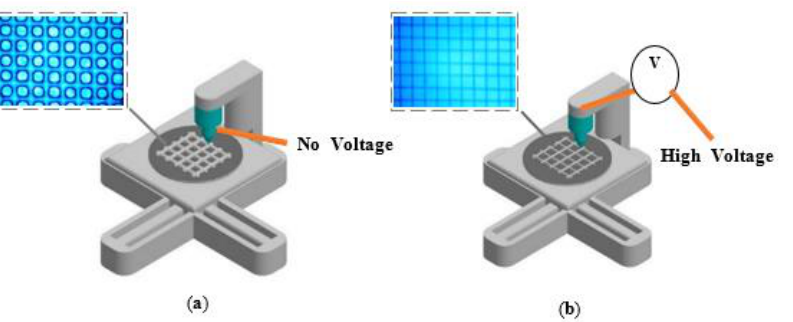
Figure 1. Two types of printing methods to fabricate microscale PDMS mesh patterns. ( a ) Direct ink writing and ( b ) electrohydrodynamic jet printing.